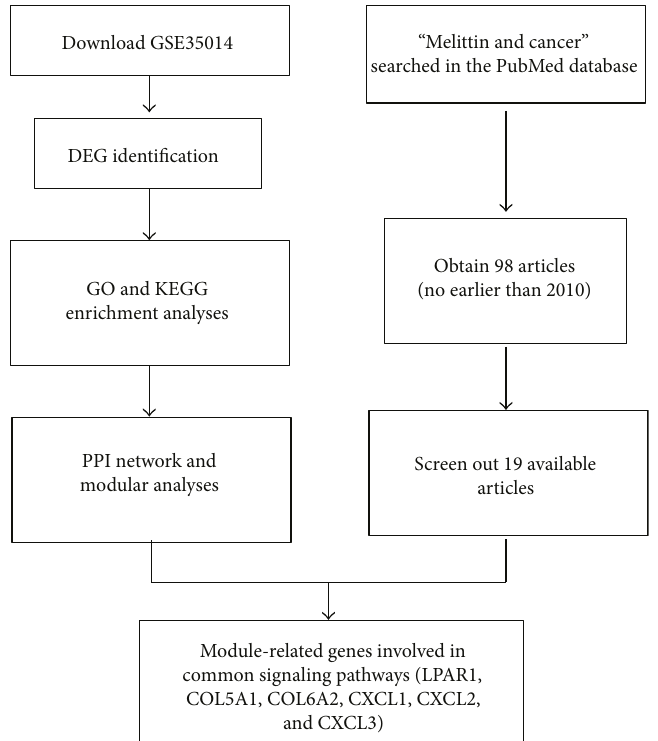
Figure 1: Data analysis pipeline for key genes in BC. DEGs: di ff erentially expressed genes; GO: gene ontology; KEGG: Kyoto Encyclopedia of Genes and Genomes; PPI: protein – protein interaction; BC: bladder